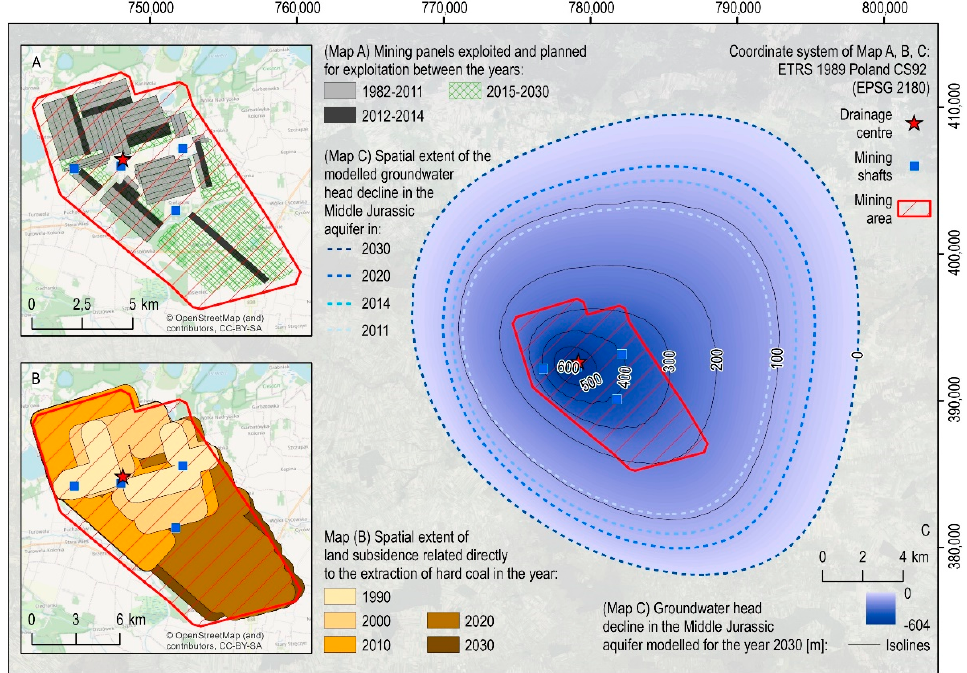
Figure 4. ( A ) The spatial distribution of selected mining fields and mining shafts of the “Bogdanka” mine; ( B ) the spatial extent of land subsidence resulting from the migration of the post-mining void (land subsidence resulting directly from mining exploitation of the hard coal) in 1990, 2000, 2010, 2020 and 2030 estimated based on the Knothe influence function, modified after Guzy and Malinowska [67]; ( C ) the spatial extent of the depression cone and groundwater head decrease in the Middle Jurassic aquifer in 2011, 2014, 2020 and 2030 estimated based on the hydrogeological modelling, modified after Guzy and Malinowska [67]. Source of data: the Mine and Surveying Department of the “Bogdanka” mine.